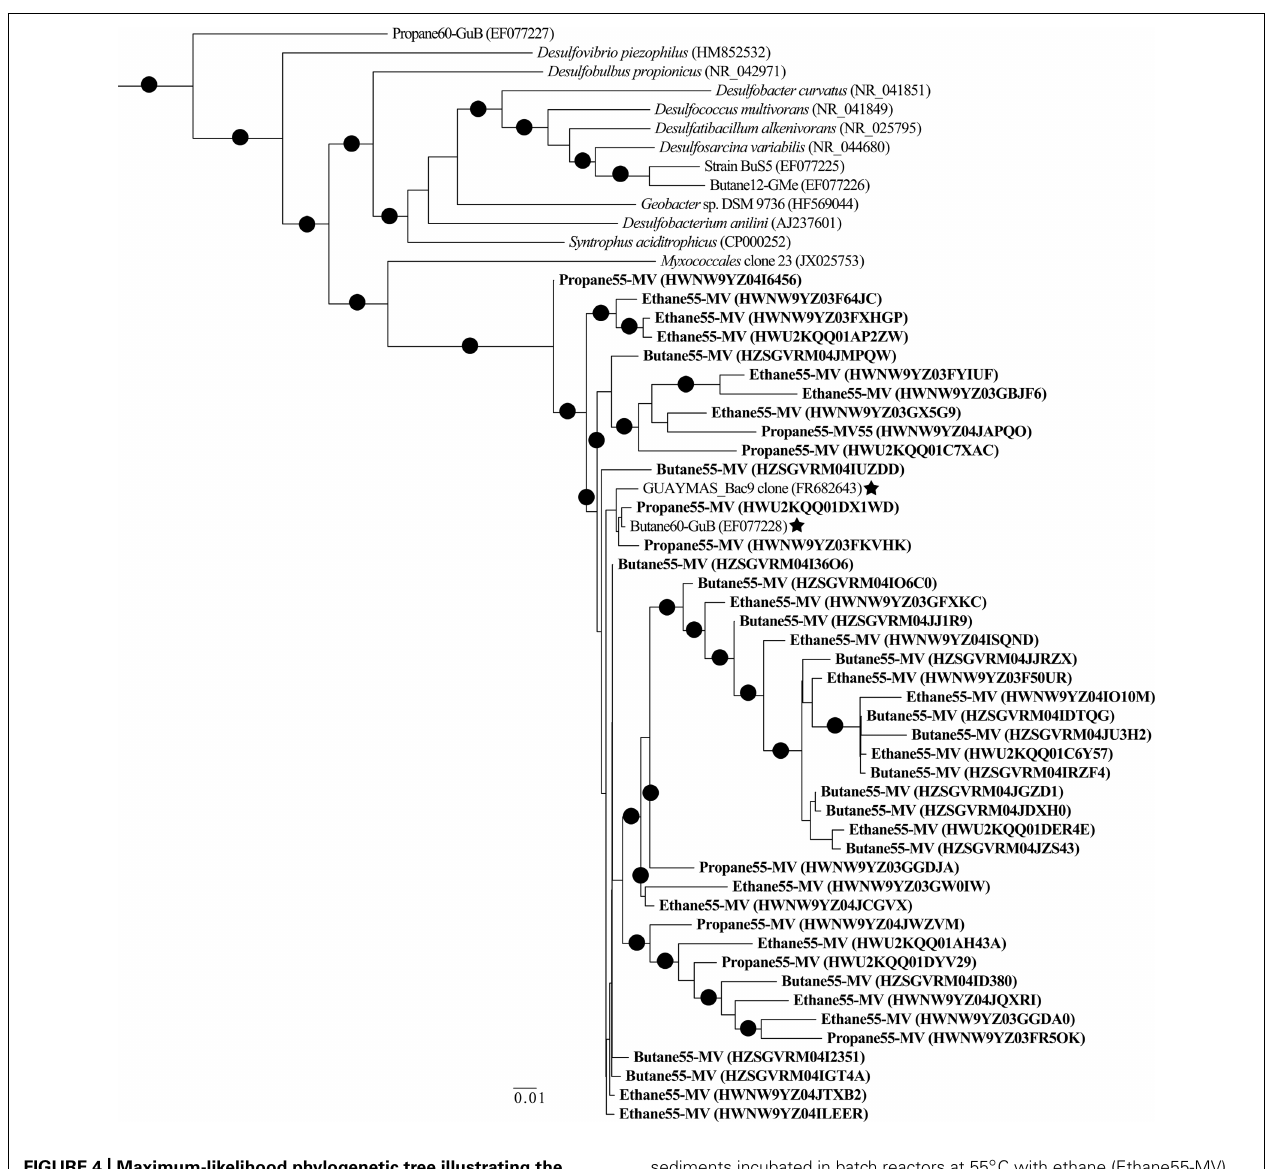
sediments incubated in batch reactors at 55 ◦ C with ethane (Ethane55-MV), propane (Propane55-MV), and butane (Butane55-MV) in bold.The most closely related environmental phylotypes from Guaymas Basin sediment sequences have been marked ( (cid:2) ).The tree was rooted to Archaeoglobus profundus DSM 5631(NR_074522). Scale = 0.01 substitutions per